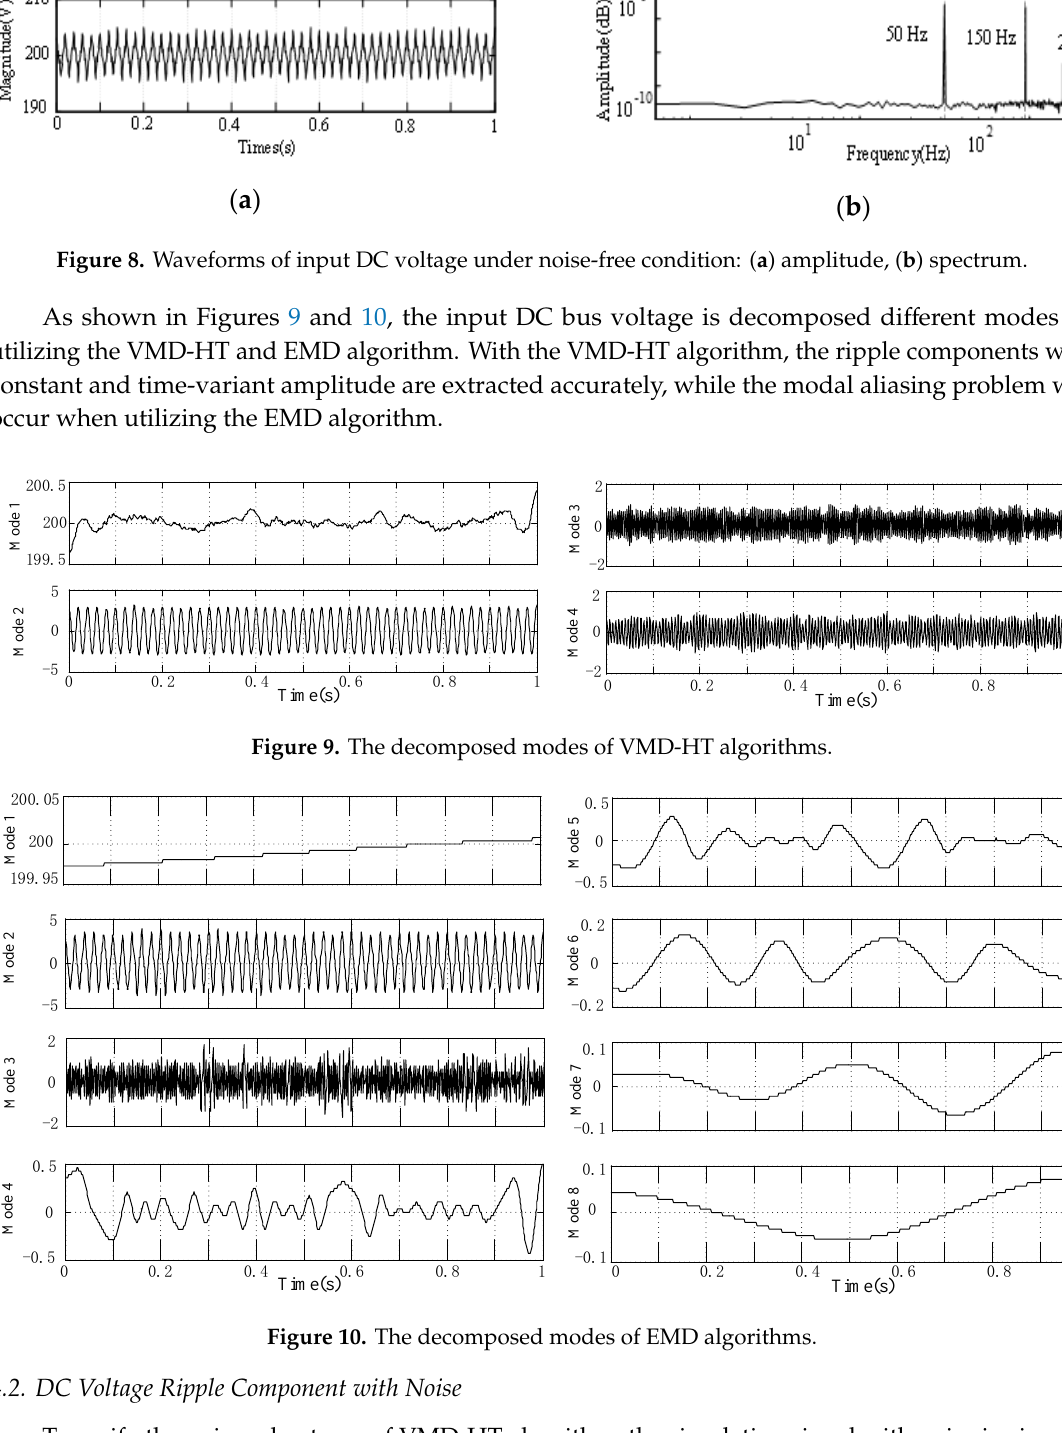
represents the noise interference, its amplitude sets to